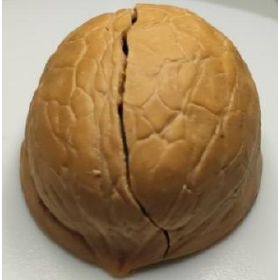
Figure 4. Walnut crack.